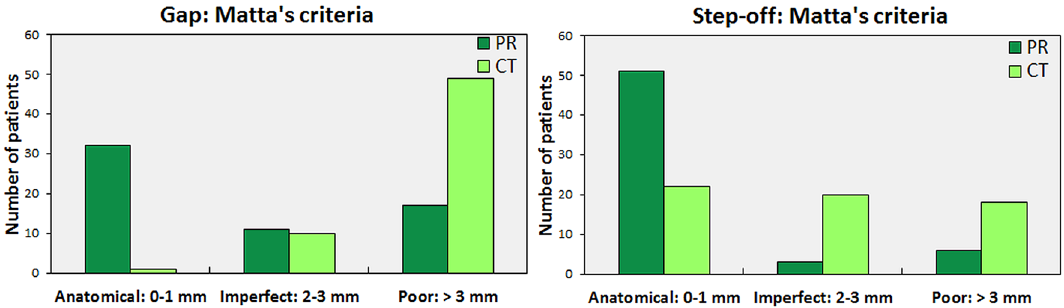
Figure 3. Grading of the residual gap ( a ) and step-off ( b ) on the postoperative radiographs (dark green) in comparison to CT scans (light green), according to Matta’s